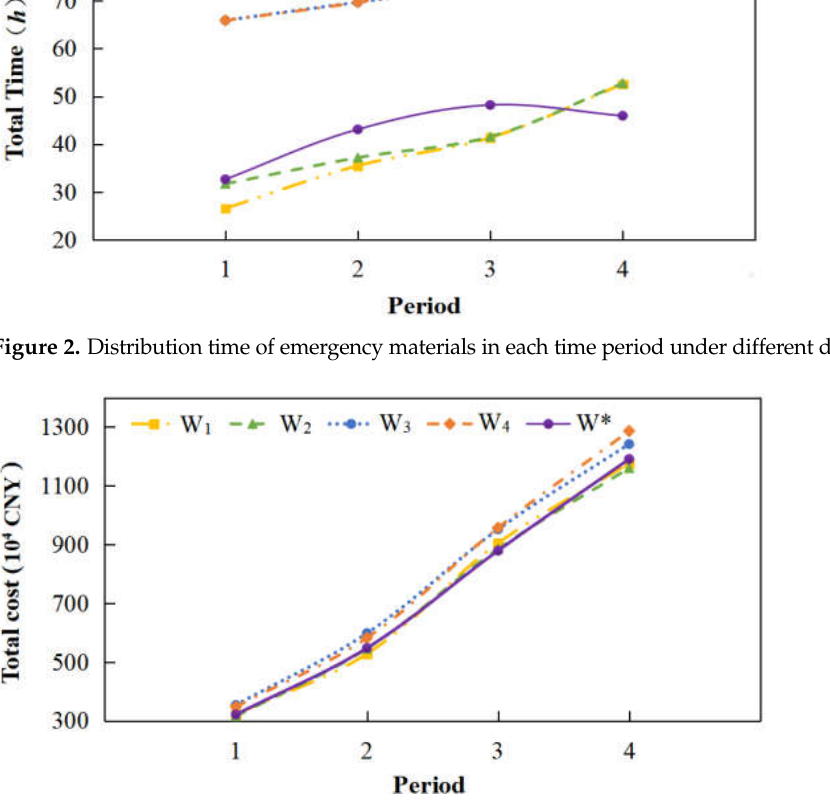
Figure 3. Distribution cost of emergency materials in each time period under different decision criteria.